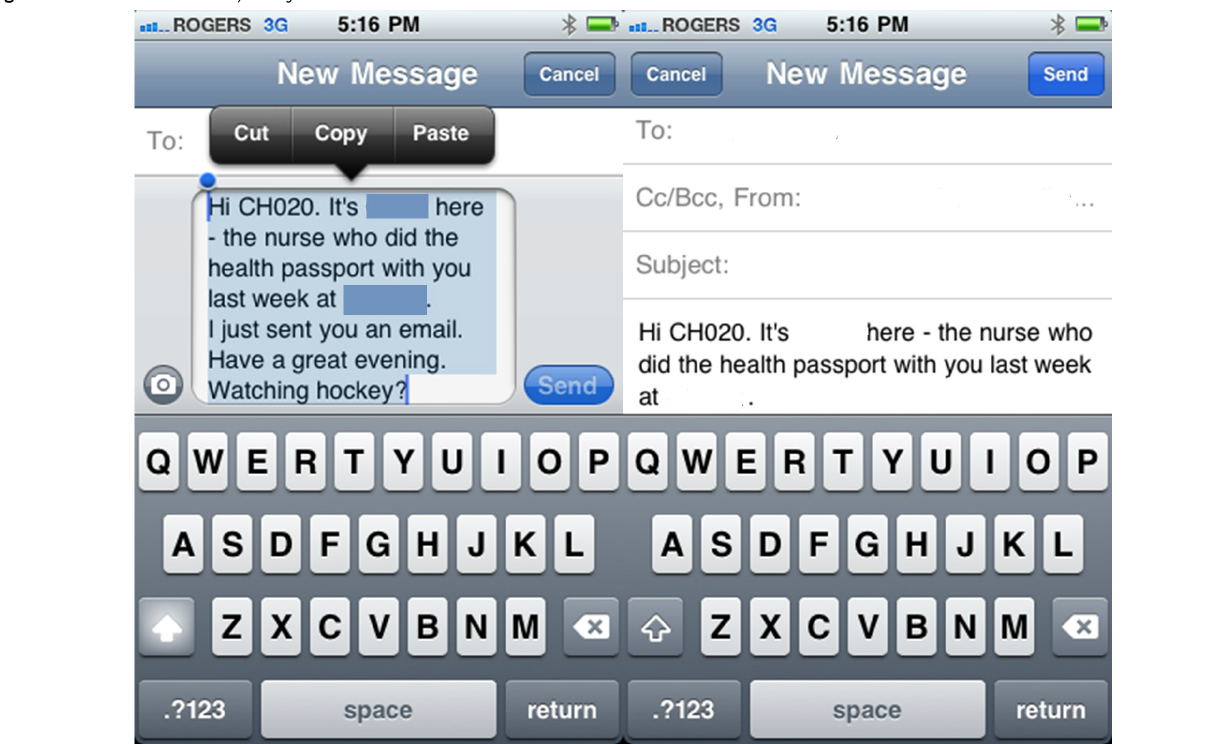
Figure 2. Consolidated texts, anonymized and emailed.